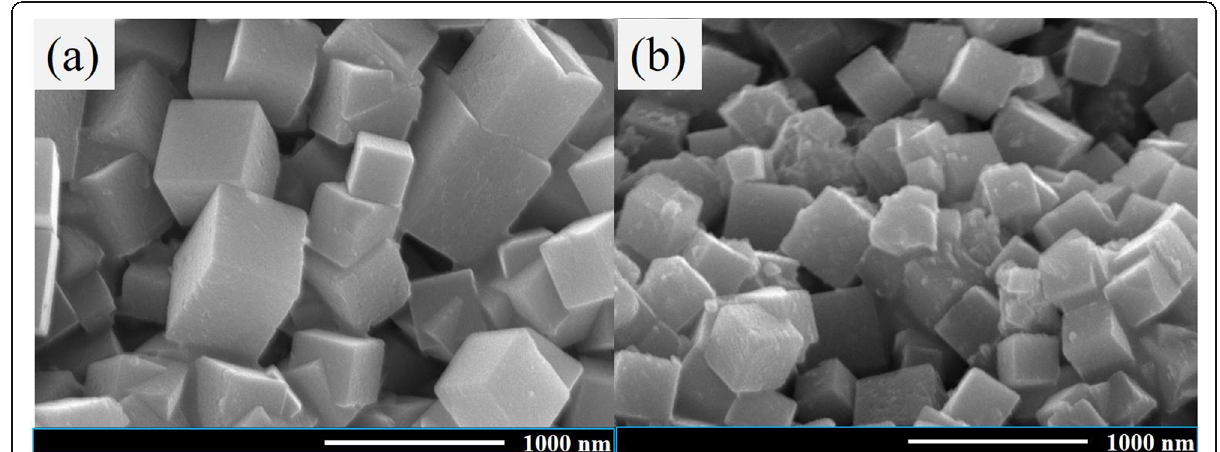
Fig. 4 SEM images of ZHS ( a ) and 20% Ag:cZHS ( b